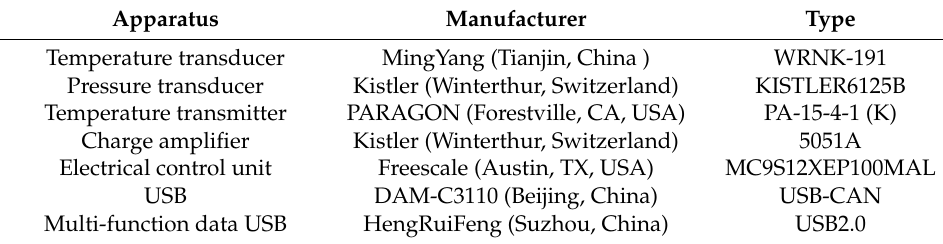
Table 2. Methanol equivalent ratio test data.